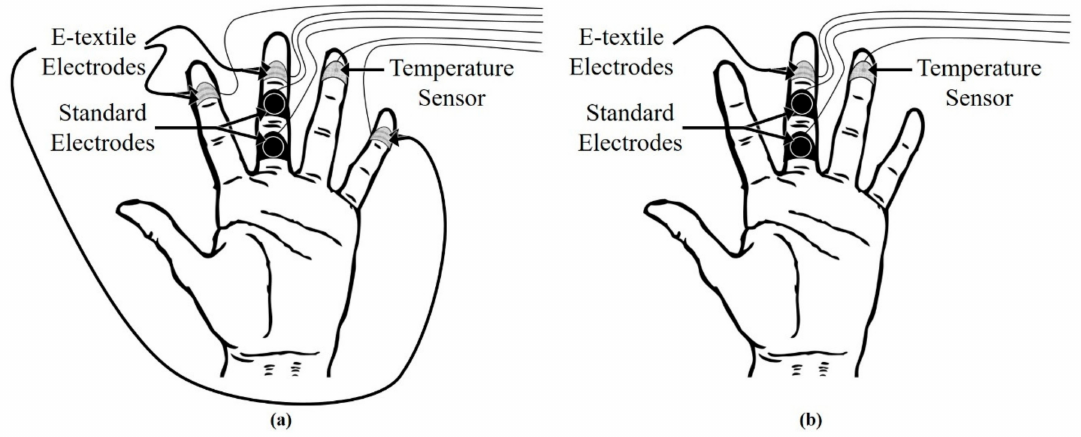
Figure 2. Schematics illustrating the location of the sensors for the ( a ) 15-min tests and ( b ) 4-h